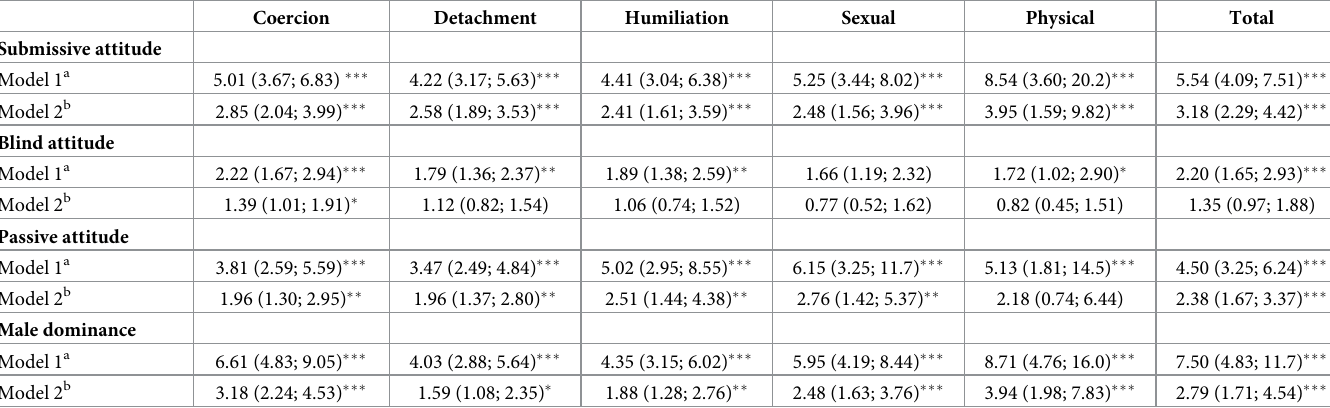
Model 1 adjusted for age, degree, age of the first sexual relationship, number of partners, continuity with the relationship and family history of IPV. b Model 2 additionally adjusted for the complementary GR. �